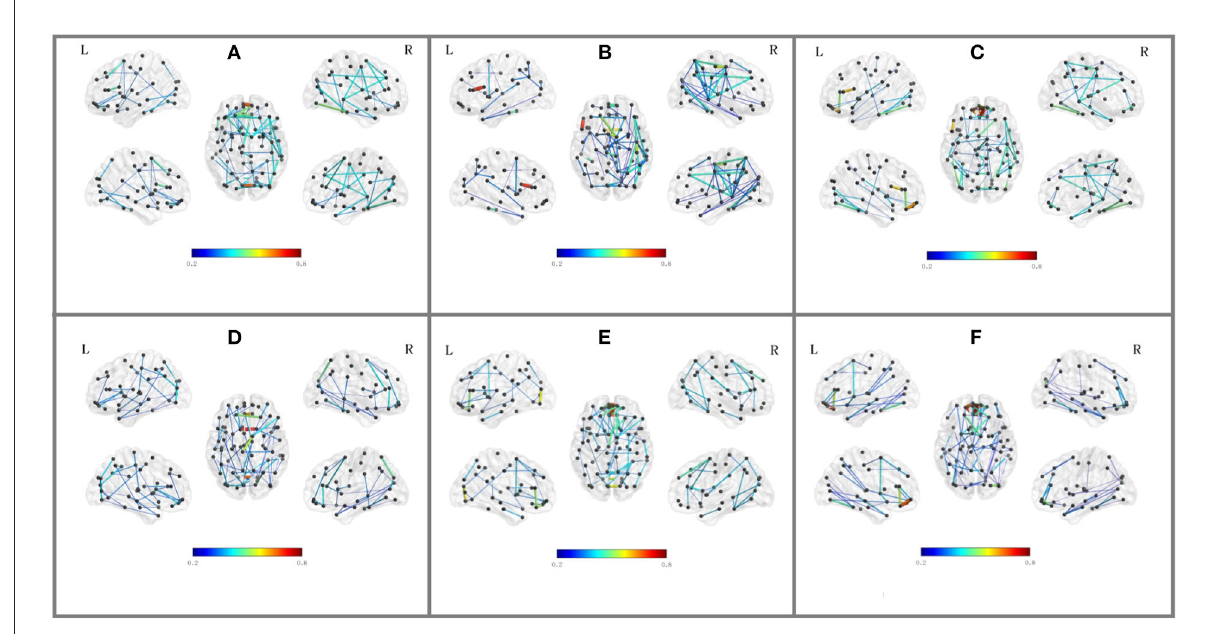
FIGURE10 Top 2 % altered functional connections in strength evaluation in the six classification scenarios. Each subfigure shares the same color bar, which means the absolute connection strength. (A) NC vs. SMC. (B) NC vs. EMCI. (C) NC vs. LMCI. (D) SMC vs. EMCI. (E) SMC vs. LMCI. (F) EMCI vs. LMCI.